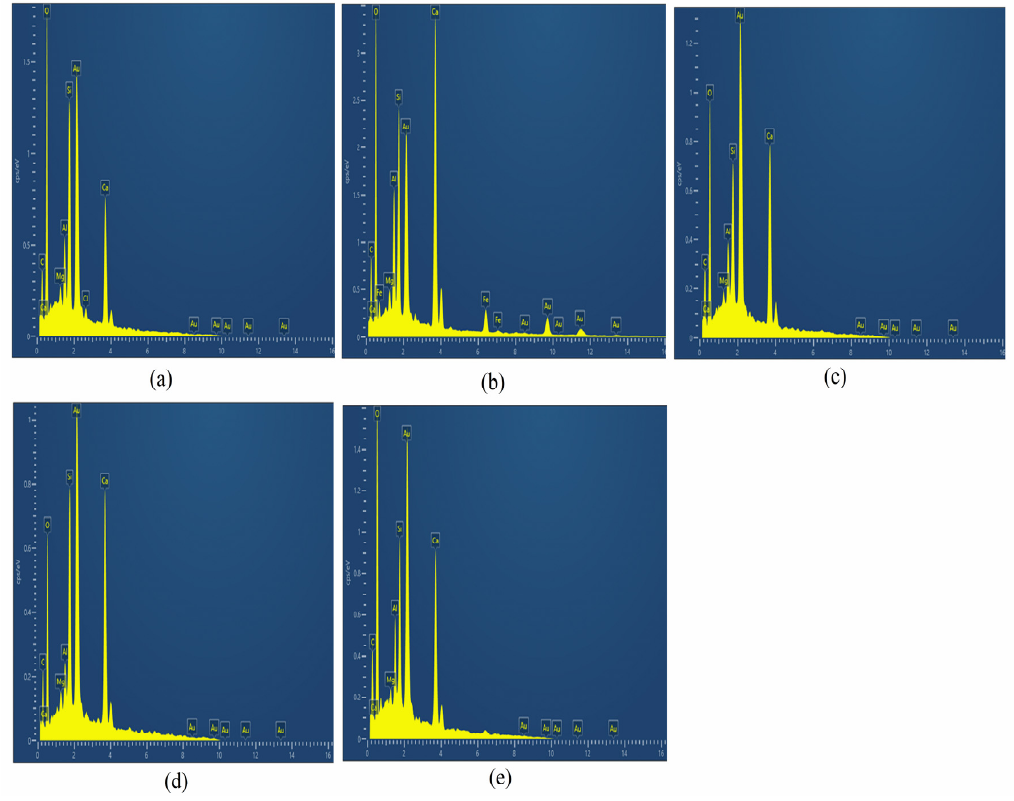
Figure 8. EDX of CM-UFS-GO composites. ( a ) CM1; ( b ) CM2; ( c ) CM3; ( d ) CM4; and ( e ) CM5.